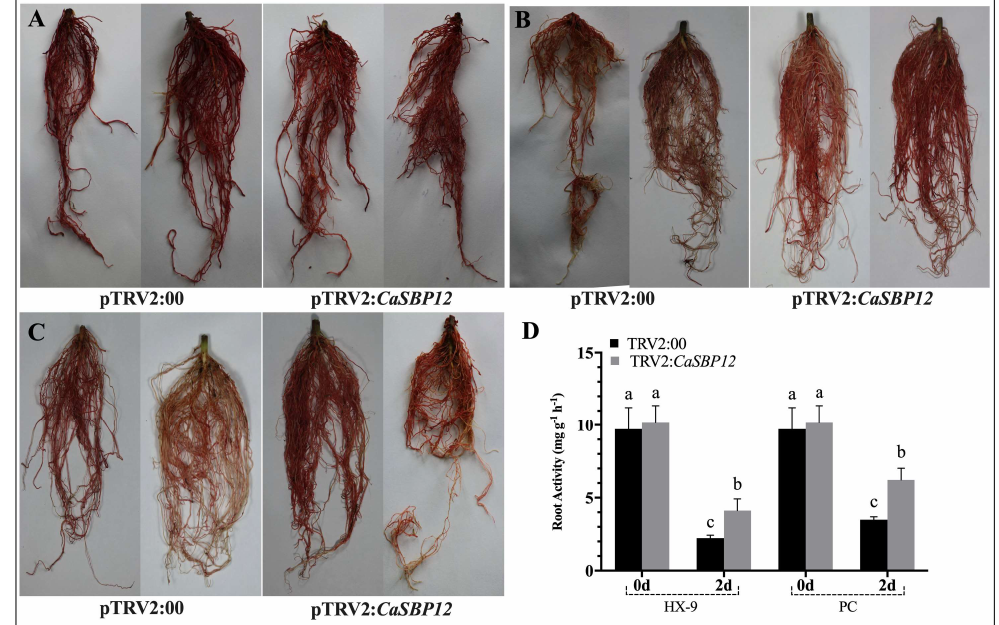
Figure 6. Determination of root activity of the silenced and control plants after inoculation with P. capsici strains ( A ) Phenotypes of the silenced and control plant roots stained with triphenyl-tetrazolium chloride (TTC) after inoculation with P. capsici at 0 d. ( B ) Phenotypes of the silenced and control plant roots stained with TTC after inoculation with the HX-9 strain of P. capsici at 2 d. ( C ) Phenotypes of the silenced and control plant roots stained with TTC after inoculation with the PC strain of P. capsici at 2 d. ( D ) Roots activity of the silenced and control plants after inoculation with P. capsici strains at 2 d. The means were analyzed using the least significant difference (LSD). Bars with different lower-case letters indicate significant differences at p ≤ 0.05. Mean values and SEs for three replicates are shown.